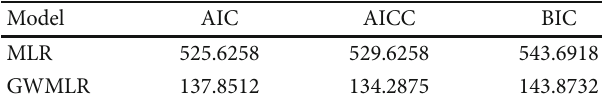
Table 6: The Akaike ’ s information criterion (AIC), corrected AIC (AICC), and Bayesian information criterion (BIC) values of the multivariate logistic regression (MLR) and geographically weighted MLR (GWMLR)